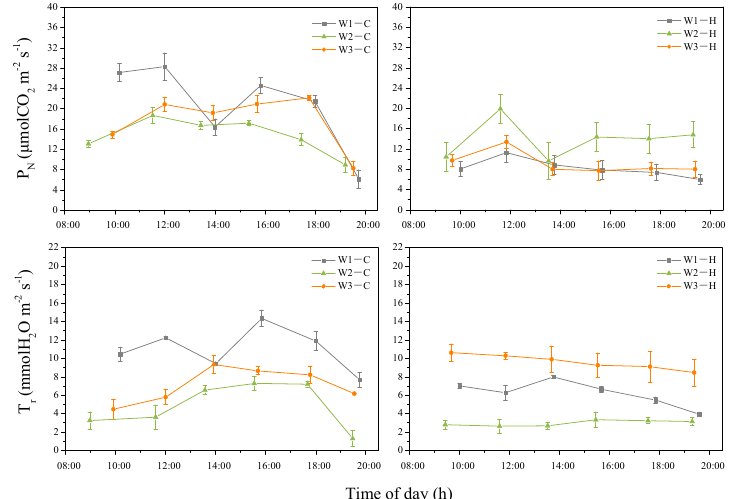
Figure 5. Diurnal changes in the net photosynthetic rate (P N ) and transpiration (T r ) of C. mongolicum ( C ) and H. ammodendron ( H ) in the low (W1), medium (W2) and high (W3) irrigation amounts. Transpiration (T r ) for the different irrigation levels generally exhibited a similar pattern to net photosynthesis (Figure 3). The diurnal variations of T r for C were unimodal and reached a peak at 13:30 h in the W2 and W3 treatments. On the contrary, the T r values displayed a bimodal distribution in the W1 treatment and reached peaks at 12:00 and 16:00 h. For daily mean T r (from 9:00 to 19:00) the highest values were obtained in the W1 treatment (13.25 mmol (H 2 O) m − 2 s − 1 and 16.51 mmol (H 2 O) m − 2 s − 1 ), followed by the W3 treatment (8.97 mmol (H 2 O) m − 2 s − 1 and 11.03 mmol (H 2 O) m − 2 s − 1 ) and the W2 treatment (7.24 mmol (H 2 O) m − 2 s − 1 and 9.34 mmol (H 2 O) m − 2 s − 1 . The diurnal variations of T r for H. ammodendron were unimodal and reached a peak at 15:00 h in the W1 treatment. The T r values decreased before 11:30 am and increased to reach a peak at 14:00 until sunset in the W2 and W3 treatments. The daily mean highest T r was recorded from 9:00 to 19:00 in the W1 treatment (6.23 mmol (H 2 O) m − 2 s − 1 ), followed by the W3 (5.24 mmol (H 2 O) m − 2 s − 1 ) and W2 (2.93 mmol (H 2 O) m − 2 s − 1 ) treatments. In all treatments, the diurnal changes of intercellular CO 2 concentration (C i ) of C and H exhibited a W-shaped response curve (Figure 6). The diurnal changes of L S were opposite to that of C i .